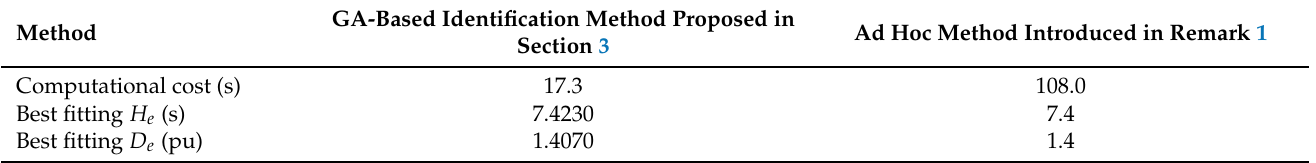
Table 4. Computational cost and the identification results of the GA-based method and ad hoc